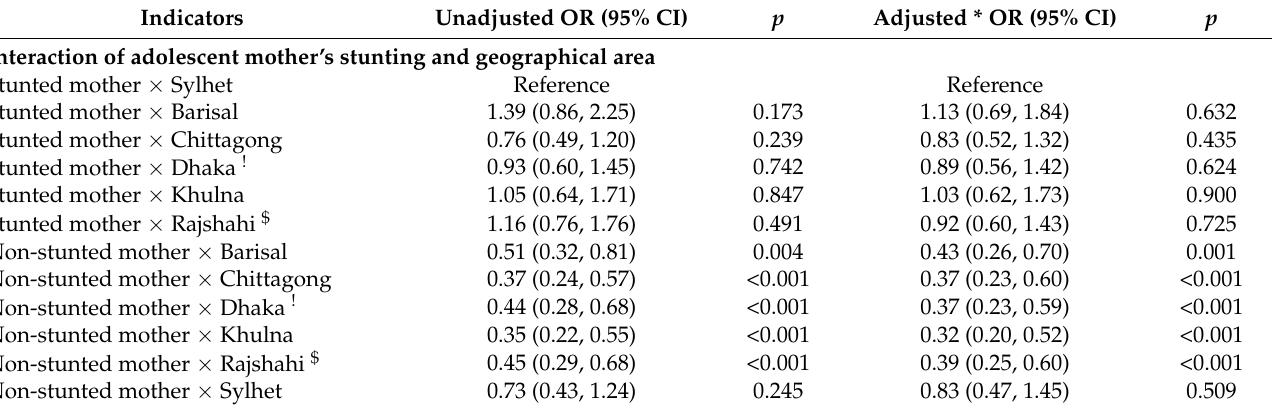
Table 4. Association between the childhood stunting and the adolescent mother’s stunting by geographical